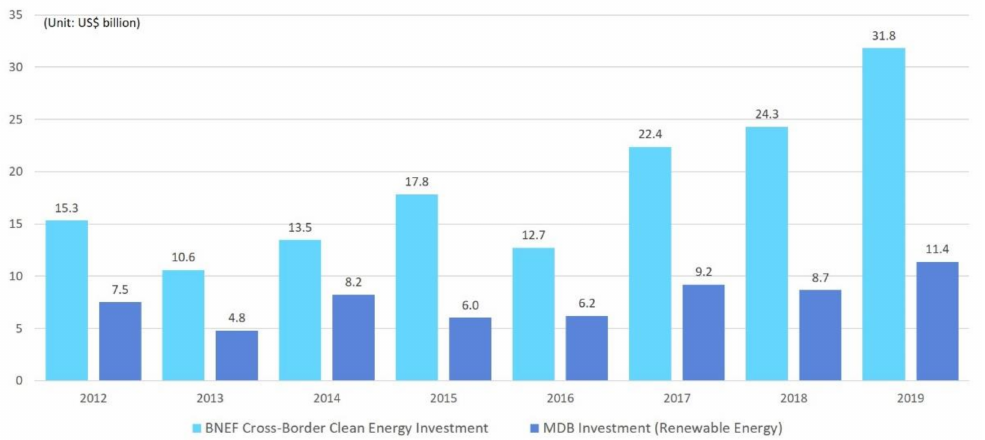
Figure 1. Cross-border private investment and MDBs’ investment in renewable energy. Source: authors’ illustration based on [34–42].